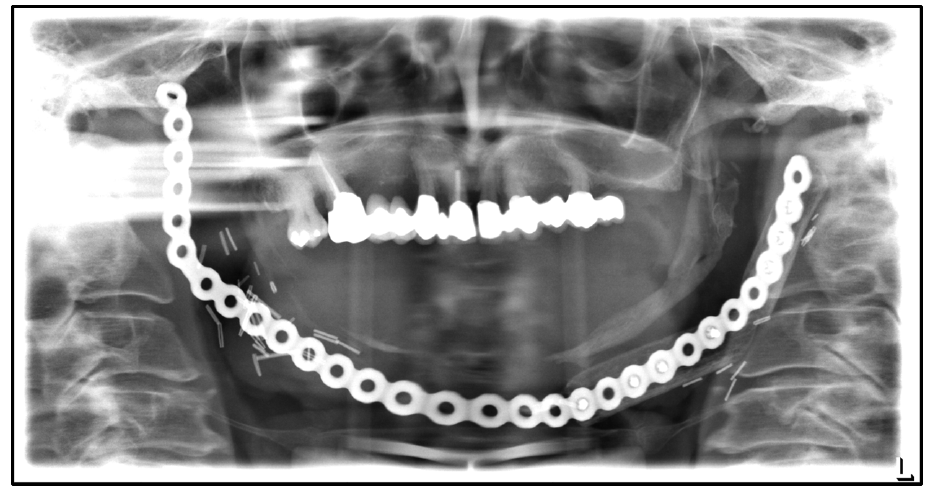
Figure 11. Dental X-ray after removal of the osteolytic destructed lateral right and anterior fibula segment and following re-osteosynthesis due to chronic inflammation.